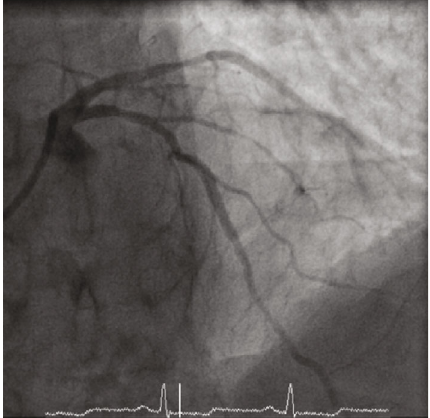
Figure 3: After administration of IV nitrates and resolution of the narrowing in the LAD.